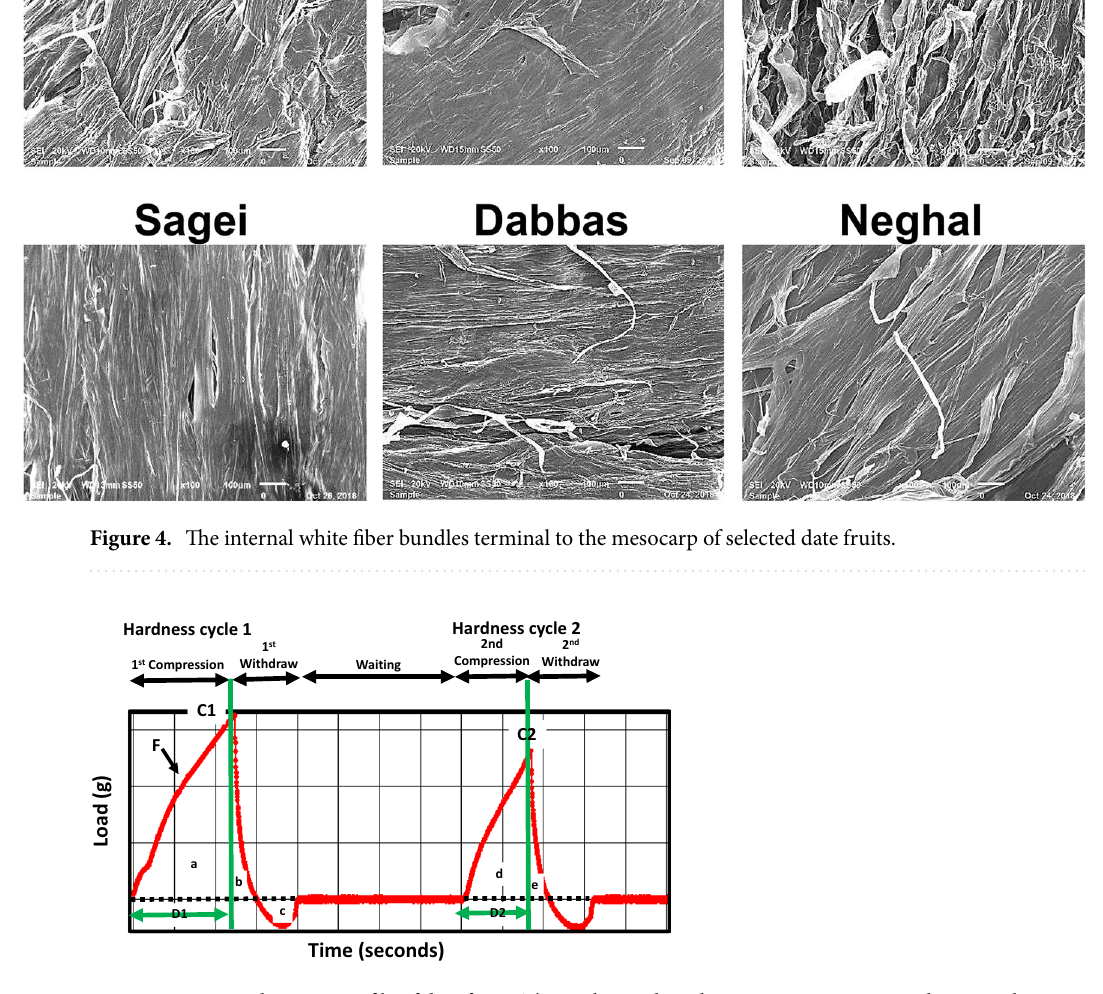
Figure 5. A typical texture profile of date fruits. The analysis is based on two-compression cycles mimicking bites with teeth. Hardness cycles 1 and 2 represent the forces required for the penetration of the food material during bite 1 and bite 2, and they are measured by the heights C1 and C2, respectively. Fracturability (F) is a measure of brittleness. Adhesiveness, a measure of stickiness to surfaces, is defined as the force necessary to pull the compressing probe out of the sample, and it is measured as the area above the curve for the first negative peak (c). Cohesiveness, or consistency, measures the internal bonds keeping the product intact and is calculated as (d + e)/(a + b). Springiness is the extent to which a deformed material returns to its initial condition and is calculated as D2/D1*100. Gumminess is the energy required to break a semisolid food into fragments, and it is calculated as the product of hardness and cohesiveness. Chewiness is the energy required to convert a solid food into a softer state suitable for consumption, and it is calculated as the product of hardness, cohesiveness, and springiness. Resilience describes the ability of the sample to return to its original form after being compressed, and it is calculated as the area under the curve after the peak force is reached divided by the area under the curve before the peak force is reached, i.e.,